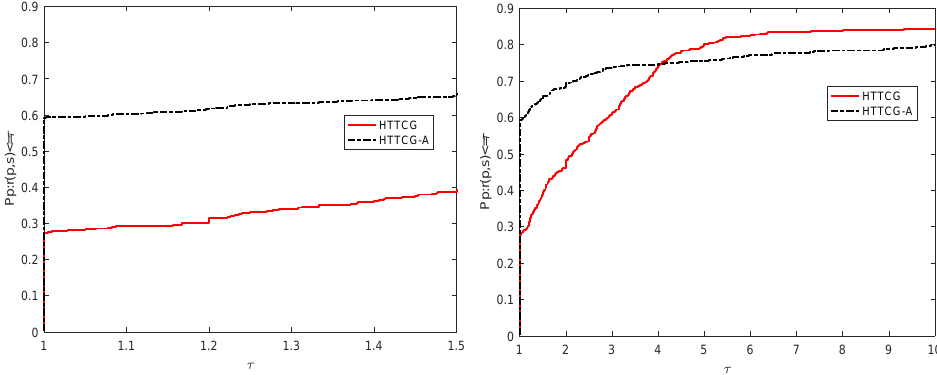
Figure 6. Performance profiles of Algorithm 2 and the acceleration form in CPU Time